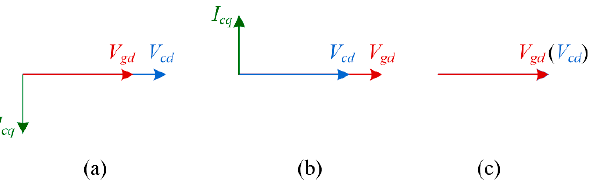
Figure 2. Vector diagrams of DSTATCOMs: ( a ) providing reactive power; ( b ) absorbing reactive power; ( c ) no reactive power exchange.